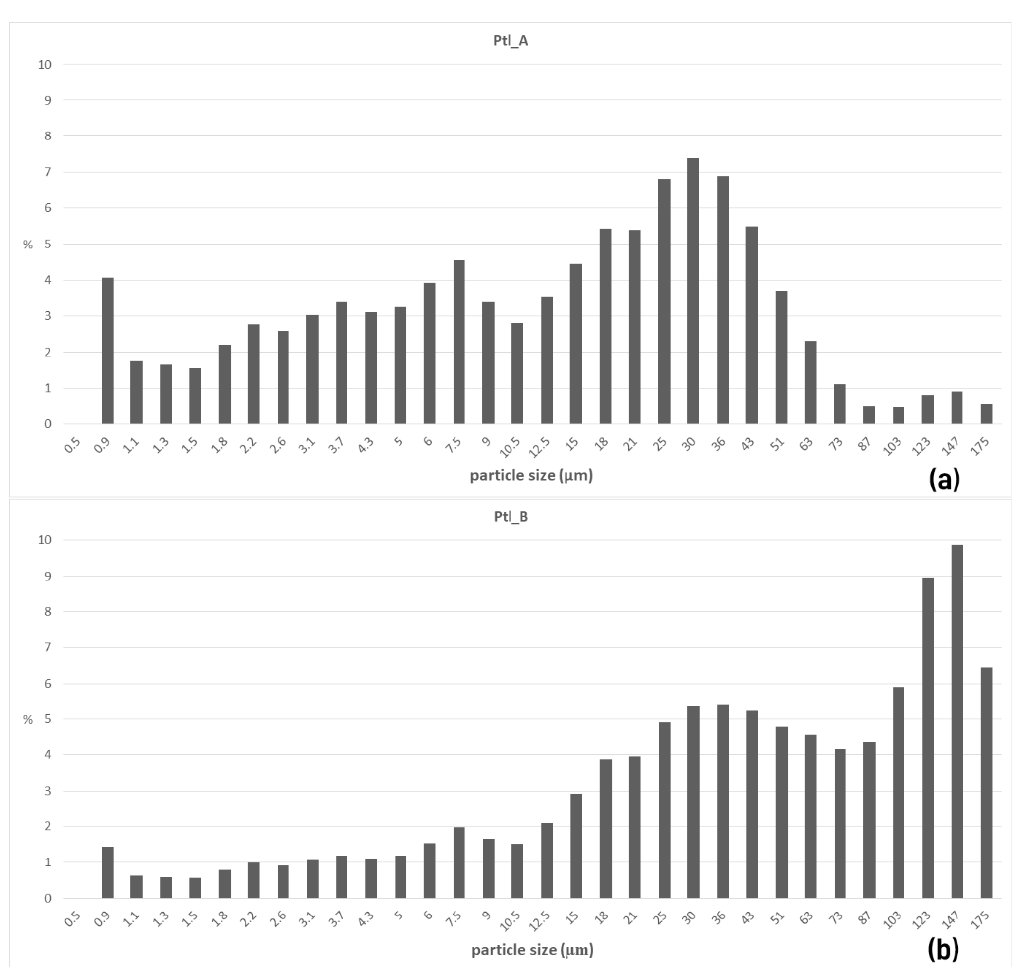
Figure 5. Granulometric distribution of TSS (total suspended solids) in PW samples for ( a ) Plt A and ( b ) Plt B.